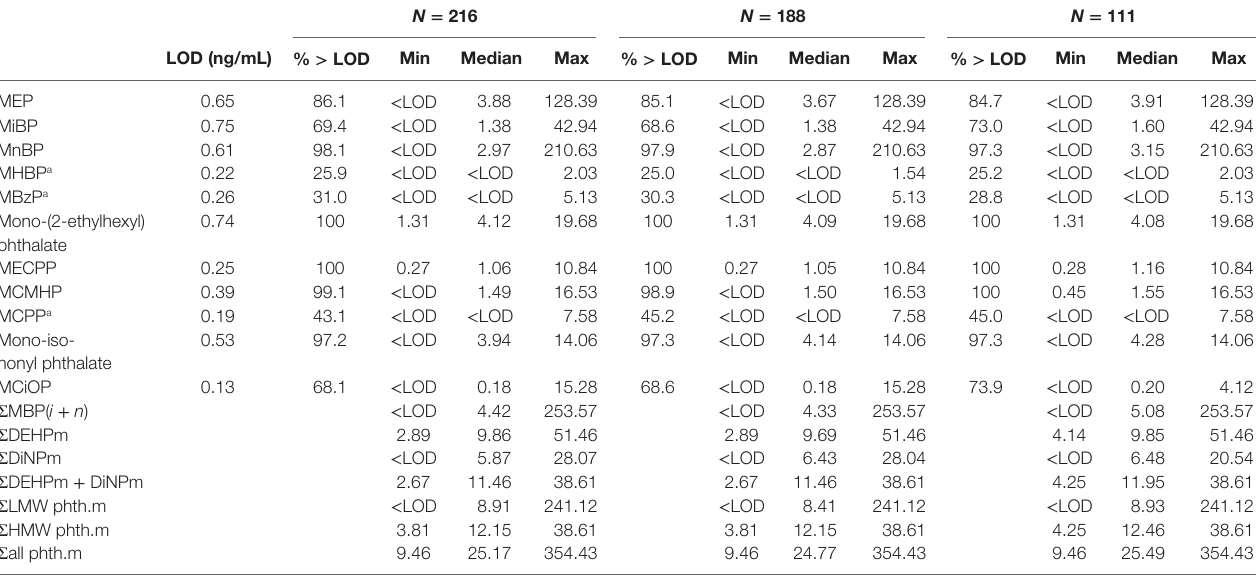
TaBle 4 | Phthalate metabolites (ng/mL) detected in maternal serum during pregnancy for male participants who had phthalates available ( N = 216), provided blood samples ( N = 188) and were in testicular function study ( N =